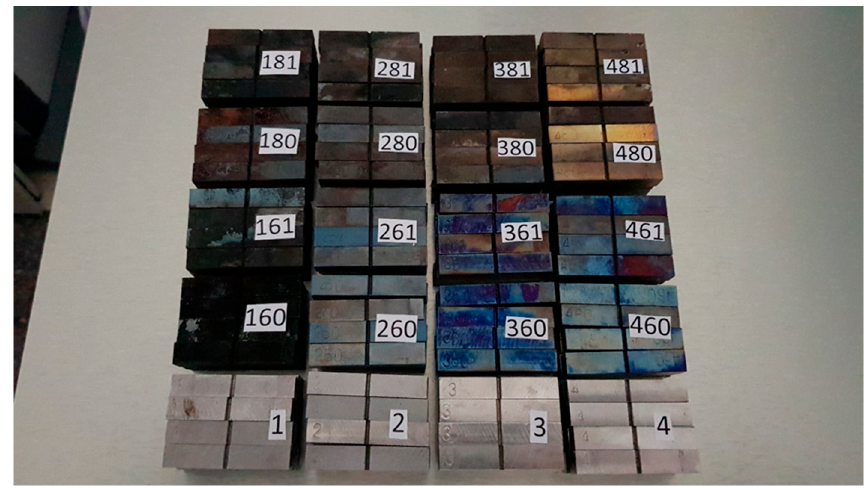
Figure 2. Samples prepared for impact strength testing, made of S355J2+N steel (1st set), X20Cr13 steel (2nd set), X6CrNiTi18-10 steel (3rd set), and X2CrNiMoN22-5-3 steel (4th set), from left to right.